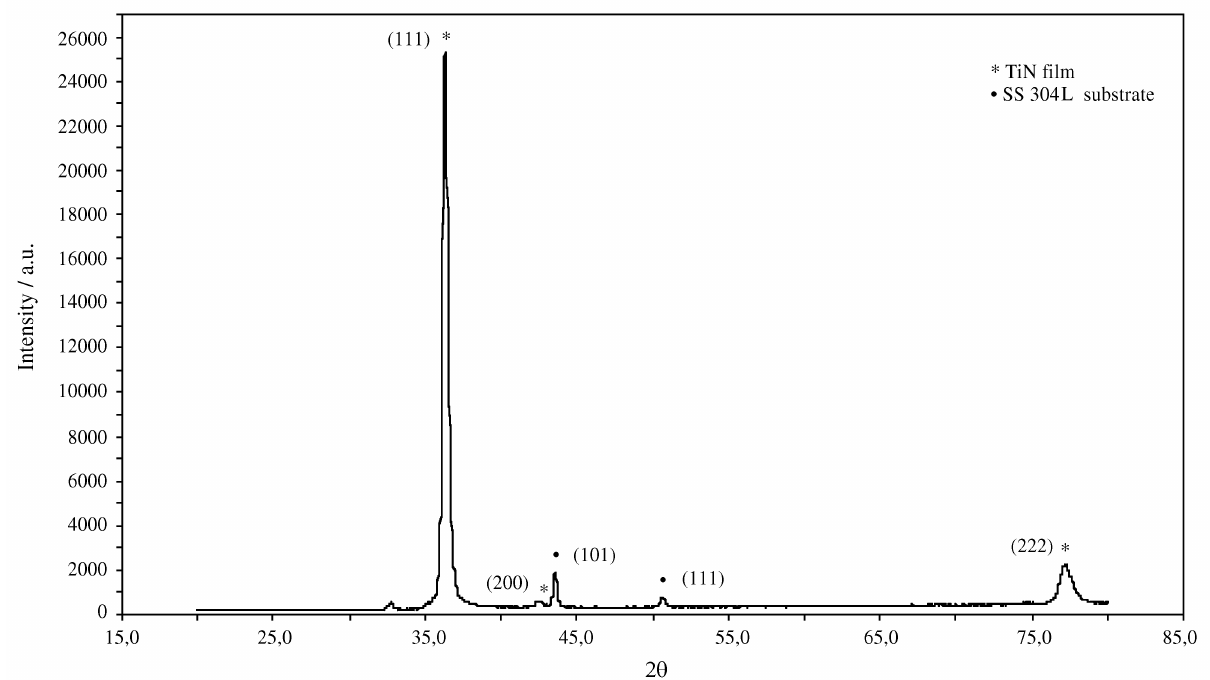
Figure 3. X-ray diffraction pattern for a TiN film without HIP treatment.